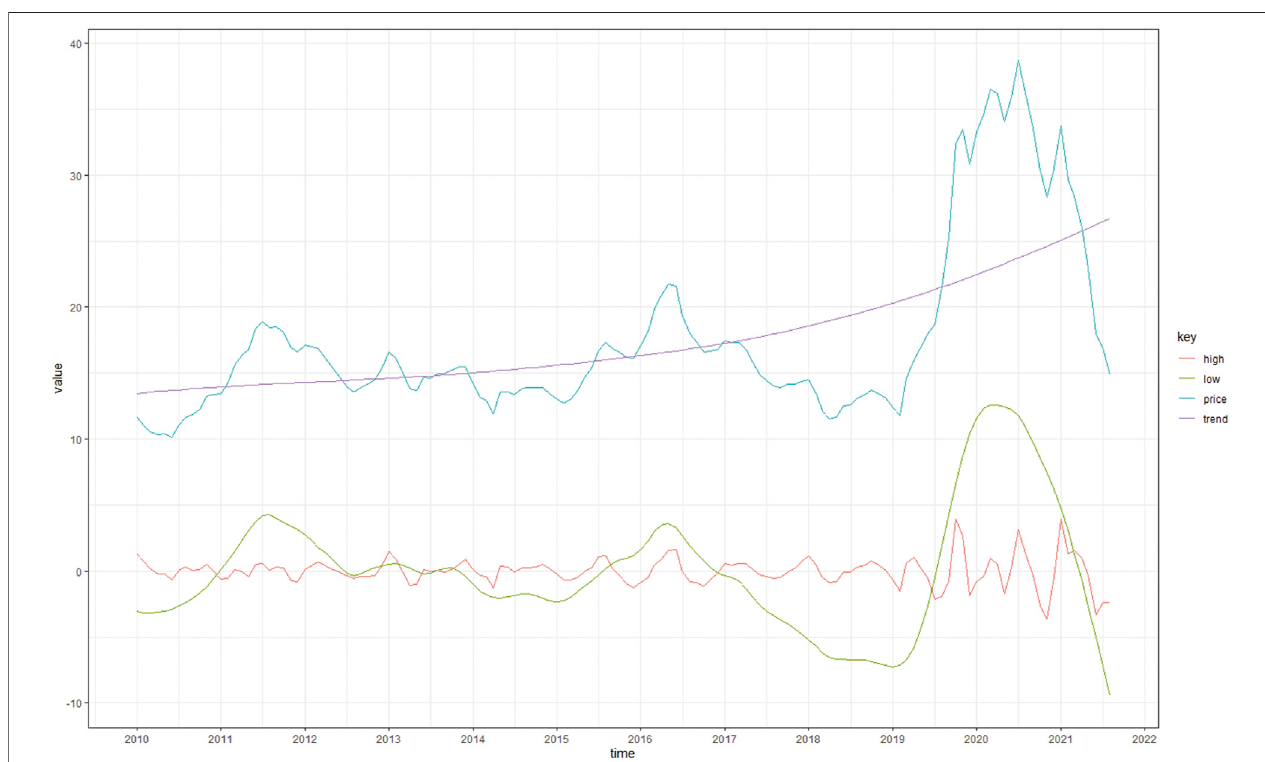
FIGURE 3 | High, low, and trend components after decomposition and reorganization of domestic hog ’ s prices.